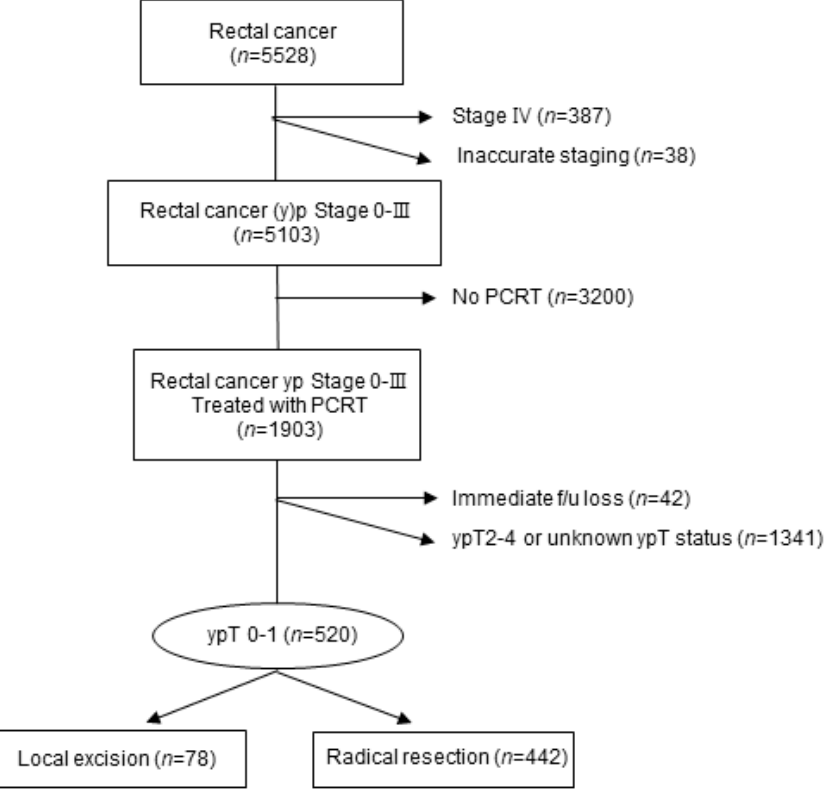
Figure 1. CONSORT diagram for patient inclusion. PCRT, preoperative chemoradiotherapy .